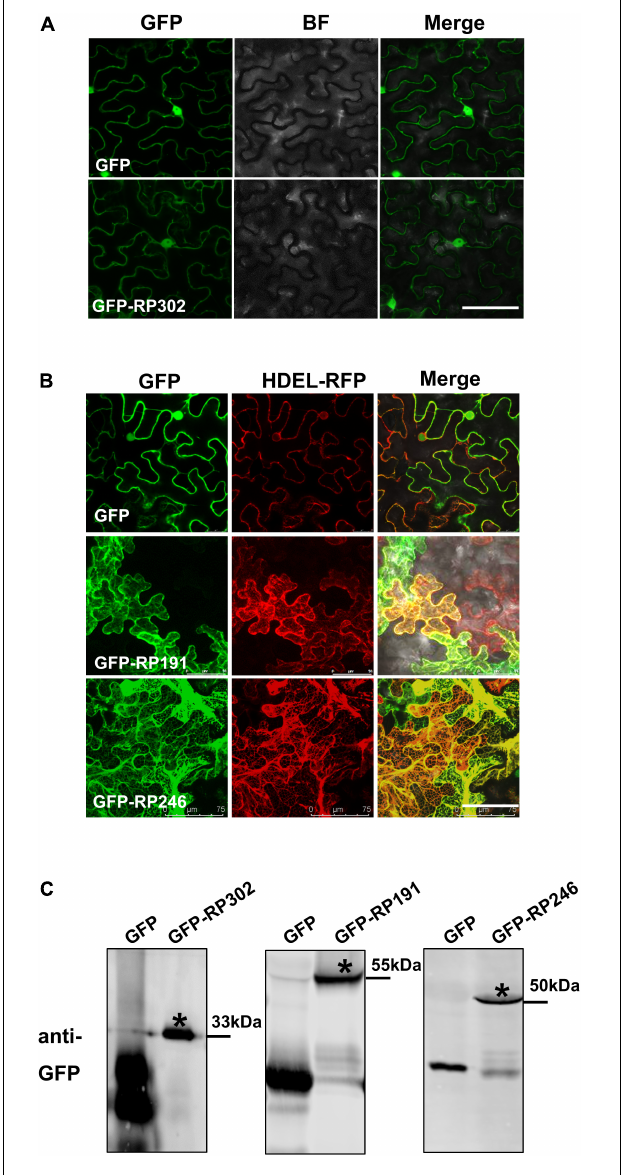
FIGURE 6 | The cellular localization of intracellular NIPs. (A) The cellular localization of GFP-RP302. (B) The cellular localization of GFP-RP246 and GFP-RP191. Green and red fluorescent protein (GFP and RFP) fusion proteins were transiently expressed in N. benthamiana using agroinfiltration and localized at 36 h after infiltration. Bar = 75 µ m. (C) Representative immunoblots showing the proteins levels of GFP, GFP-NIPs after transient expression in N. benthamiana leaves. Asterisk represents the destination